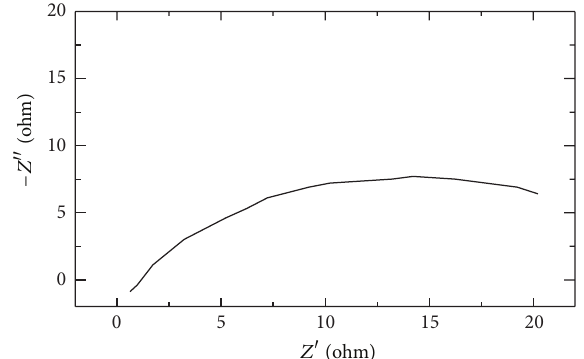
Figure 3: The AC impedance diagram of the quaternized poly- sulfone membrane. High freq. (Hz) = 1 e + 5; low freq. (Hz) = 1; amplitude (V) =